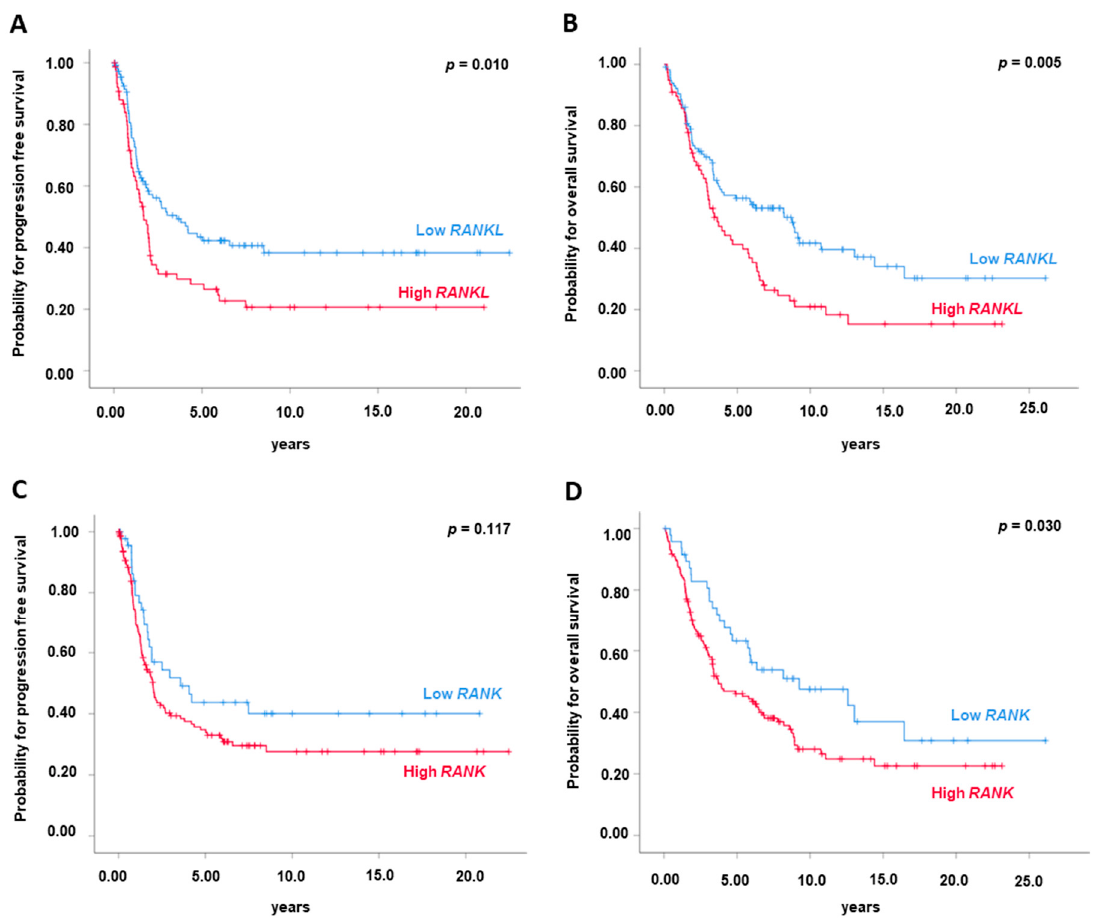
Figure 2. High RANK and RANKL mRNA expressions are associated with worse PFS and OS in OC. RANKL mRNA expression ( n = 192) and ( A ) progression free survival and ( B ) overall survival. RANK mRNA expression ( n = 192) and ( C ) progression free survival and ( D ) overall survival. RANK and RANKL mRNA expression values were normalized to TBP expression.